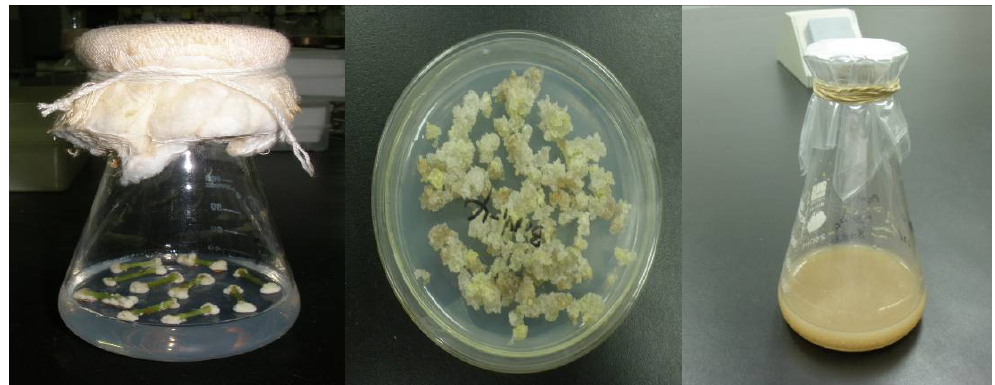
Figure 2. Stem calli, friable calli and suspension culture.